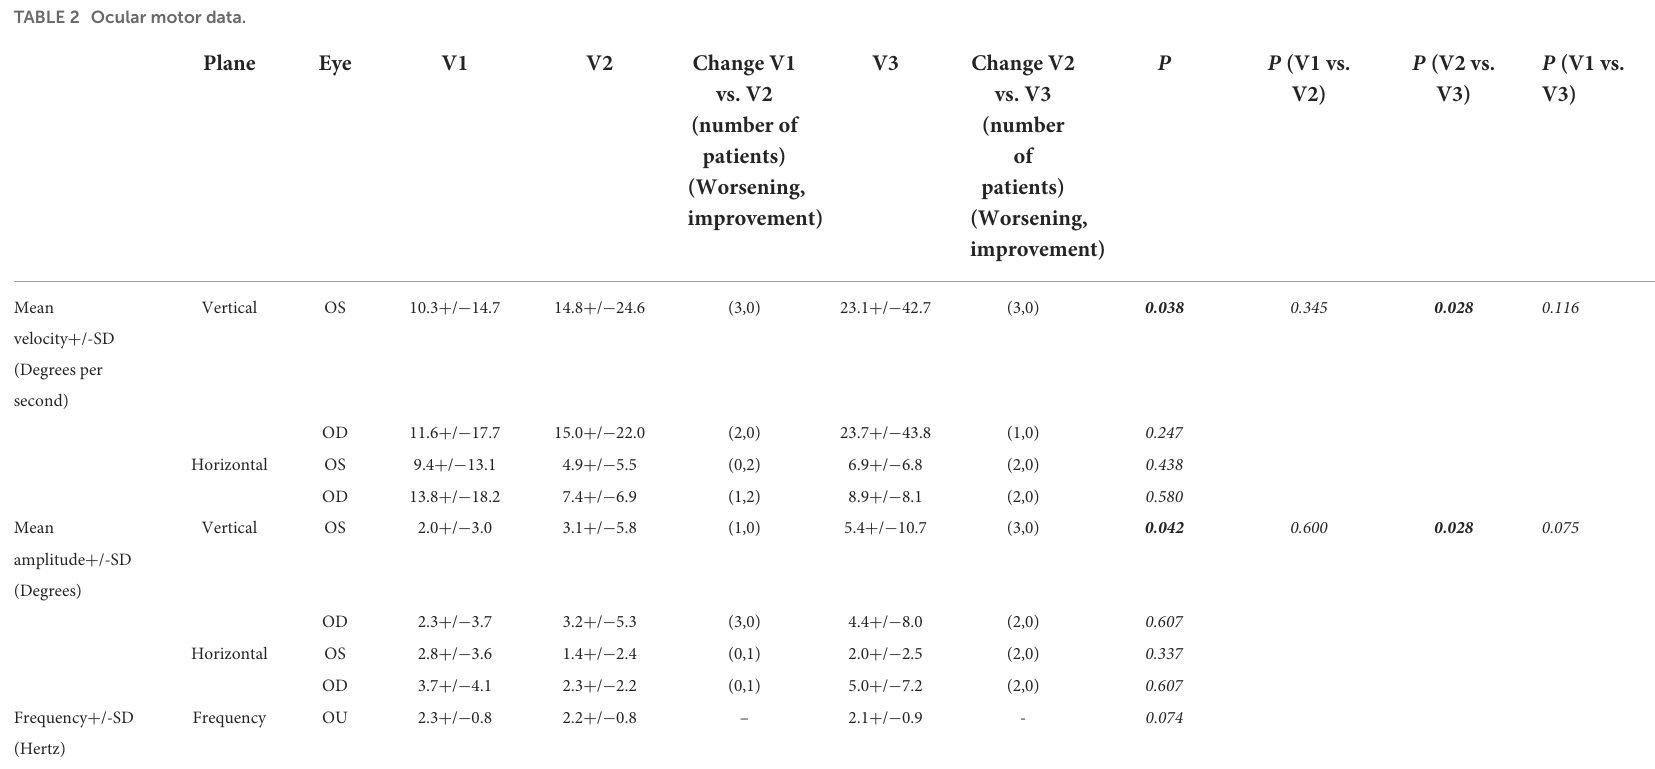
TABLE 2 Ocular motor